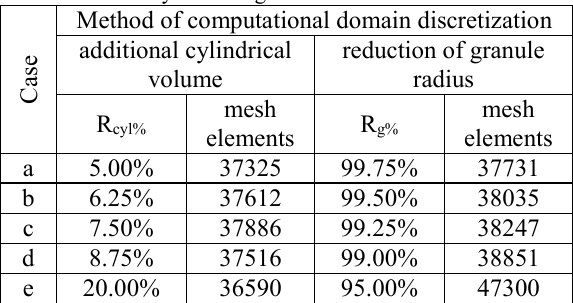
Table 1. Analysed configurations and cases.